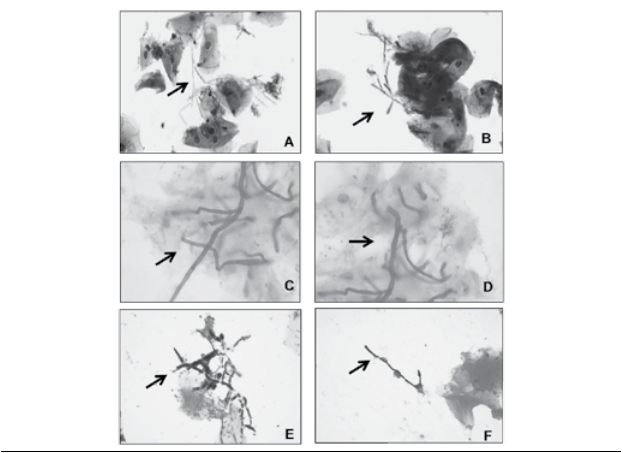
figurE 1 – Photomicrographs of Candida spp. morphological structures. Original magnification 400× (40× objective lens and 10× ocular lens). A and B) Papanicolaou staining; C and D) PAS staining; E and F: Gram staining PAS: periodic acid-Schiff; HUAP/UFF: Hospital Universitário Antônio Pedro/Universidade Federal Fluminense. Source: Pathological Anatomy